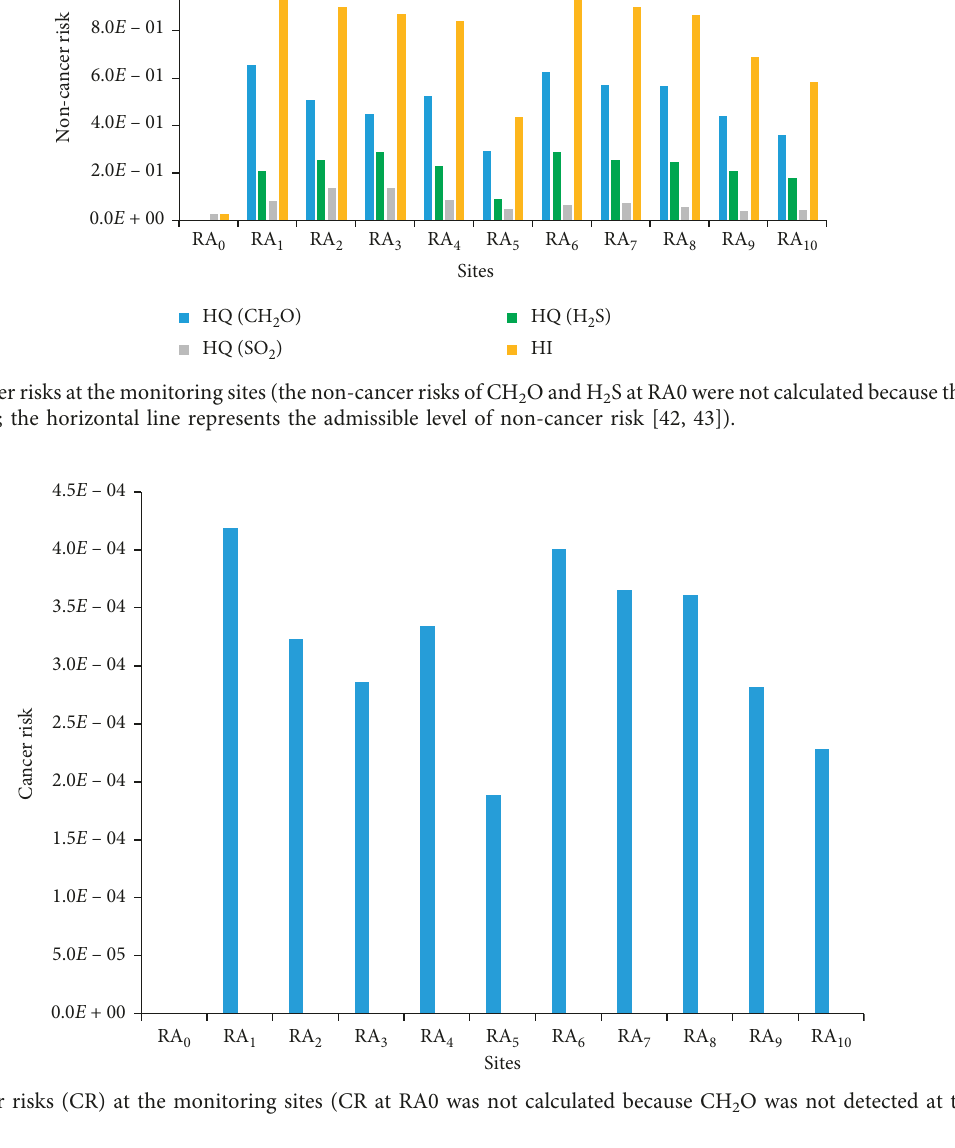
2 O was not detected at that site).